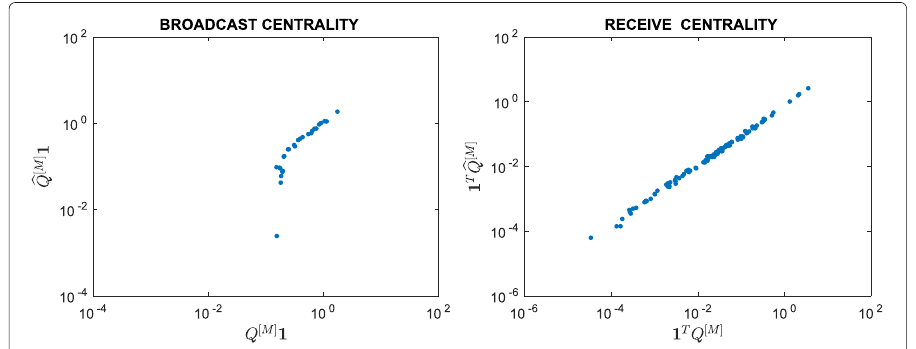
Fig. 6 Scatter plot. Real: approximation using (4) with α =